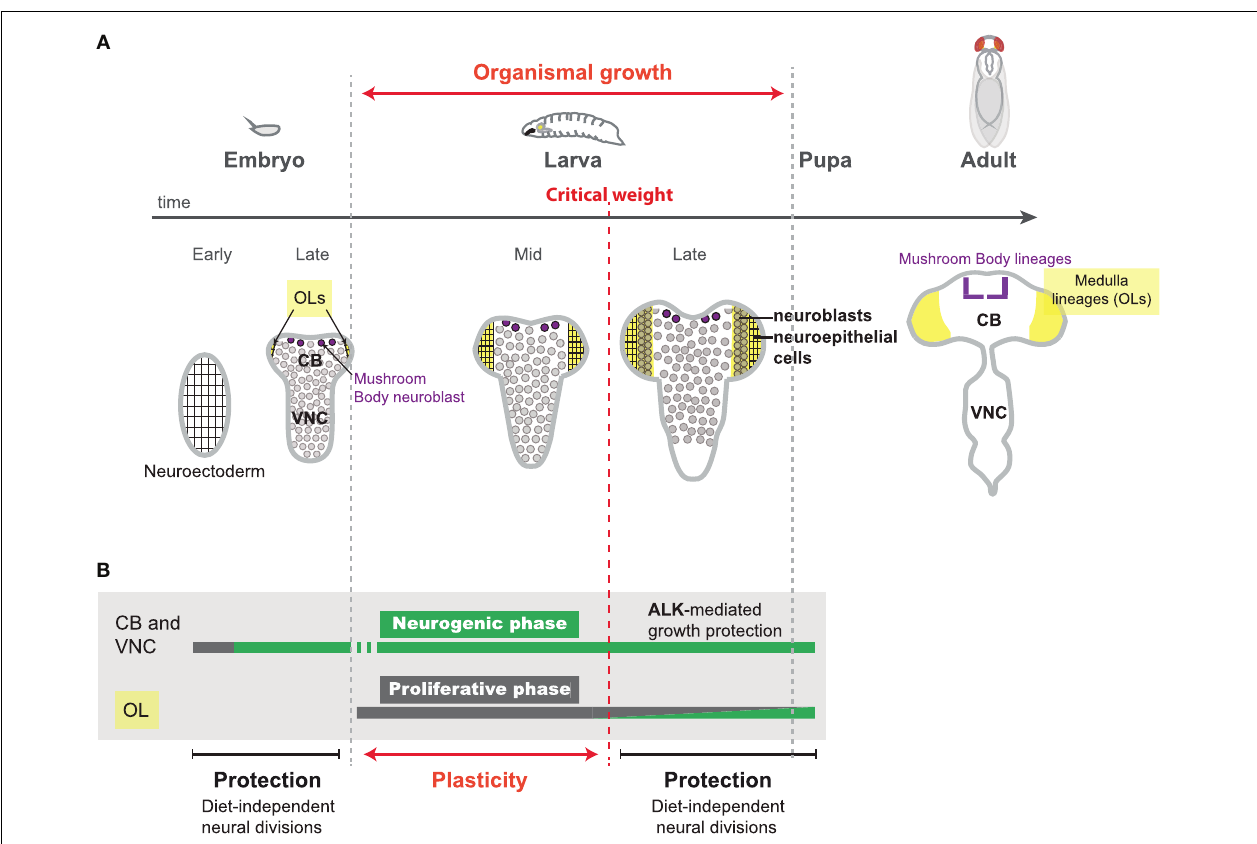
FIGURE 1 | Neural proliferation during Drosophila development. (A) The main period of growth in insect development occurs during larval stages. Upon feeding, larvae continuously and rapidly grow, reaching a so-called “critical weight.” From this moment, pulses of the steroid hormone ecdysone are produced, triggering pupariation 24hr later. Neural development starts during embryogenesis and is completed before adult hatching. During early embryonic stages, the neuroectoderm amplifies by symmetric divisions (proliferative phase). Neuroblasts of the central brain (CB) and the ventral nerve cord (VNC) delaminate from the neuroectoderm and undergo a series of asymmetric divisions to produce neurons (neurogenic phase). During larval stages, CB and VNC neuroblasts continue to produce a large number of neurons. In the optic lobes (OLs) (yellow) a neuroepithelium (rectangular